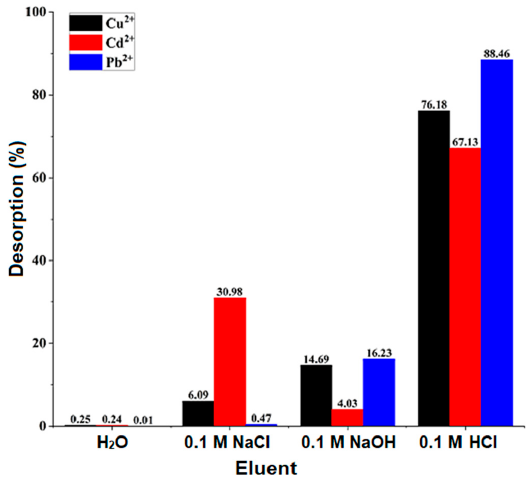
Figure 7. Desorption efficiency of metal ions from spent adsorbents (oxidized wool) in different eluent media (desorption time 1 h and working volume 15 mL).